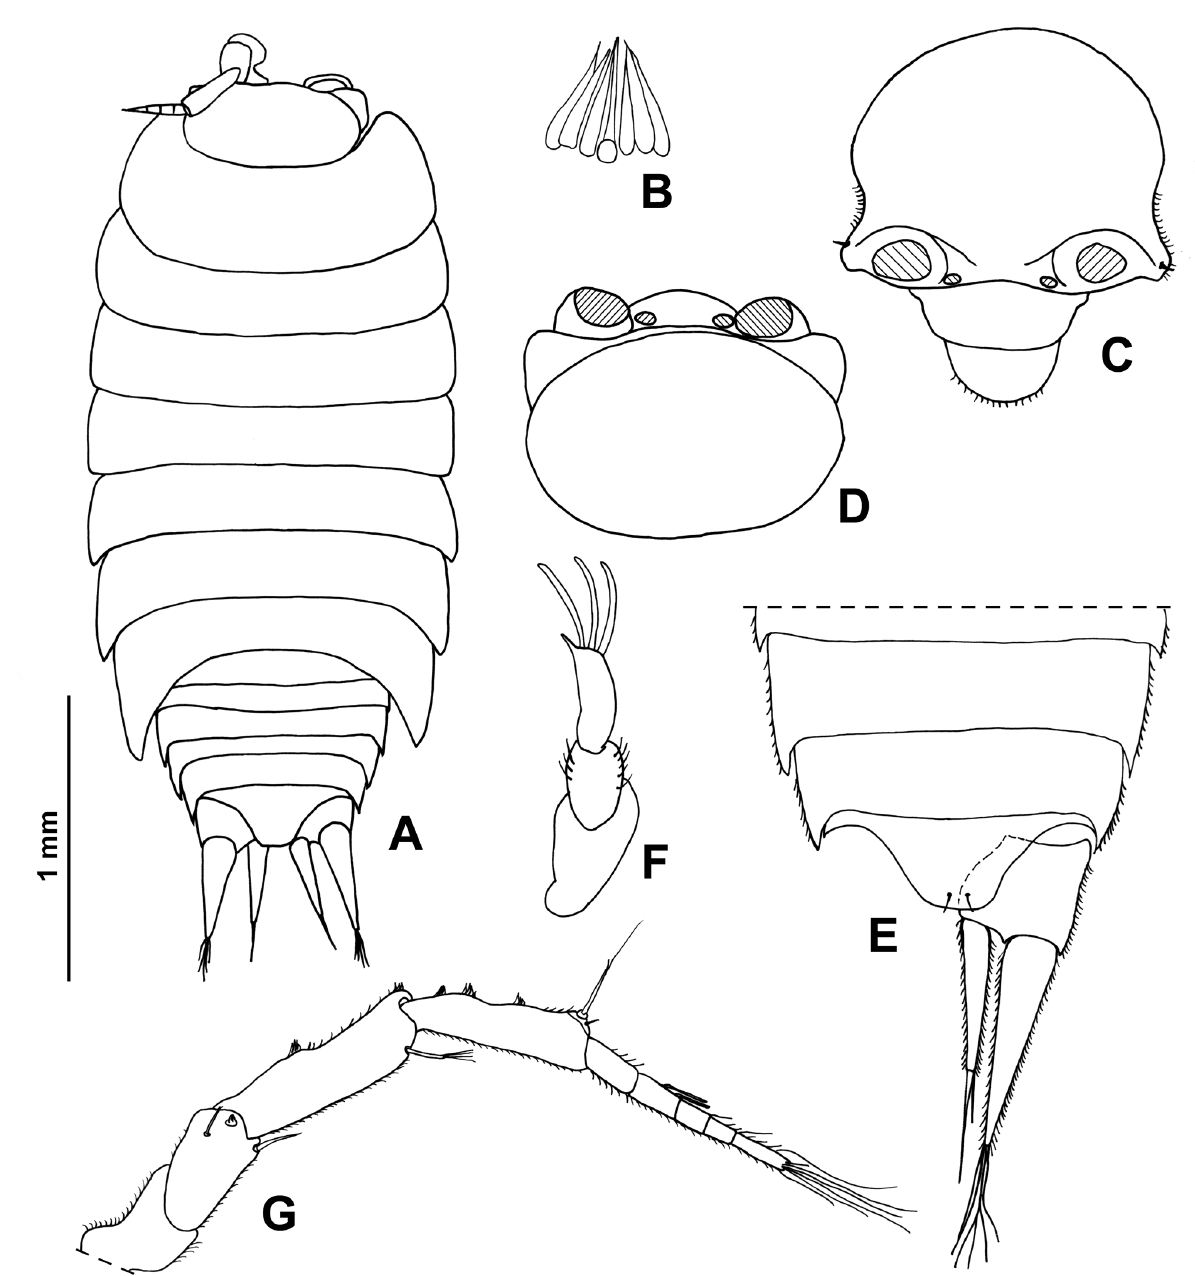
Fig. 7. Trichoniscoides sicoensis Reboleira & Taiti sp. nov. from Gruta da Cerâmica, Sicó. — Paratype, ♀. A . Specimen in dorsal view. — Paratype, ♂. B . Dorsal scale-seta. C . Cephalon in frontal view. D . Cephalon in dorsal view. E . Pleonites 4, 5, telson and right uropod. F . Antennula. G .